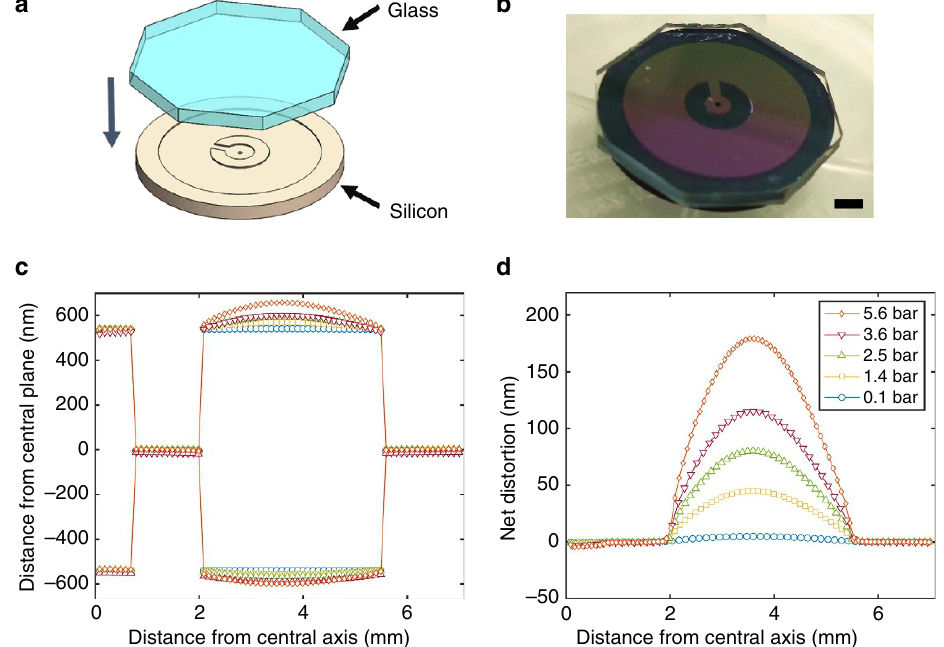
Figure 1 | Torsion pendulum head. ( a ) Schematic representation of the glass-silicon head. The 1mm thick (cid:2) 14mm diameter silicon was patterned with a 1.08 m m tall (cid:2) 11mm outer diameter/4mm inner diameter cavity before the octagonal glass lid was anodically bonded to it. The annular cavity is connected to the central fill line through a 1.25mm long (cid:2) 0.6mm wide radial channel that opens into a 1.5mm diameter central hub. ( b ) The bonded cavity before mounting on the torsion pendulum. Scale bar, 2mm. ( c ) The cross-section of the cavity under pressure. ( d ) The calculated net bowing of the cavity at the five experimental pressures investigated. ( c , d ) Calculations were done using finite element